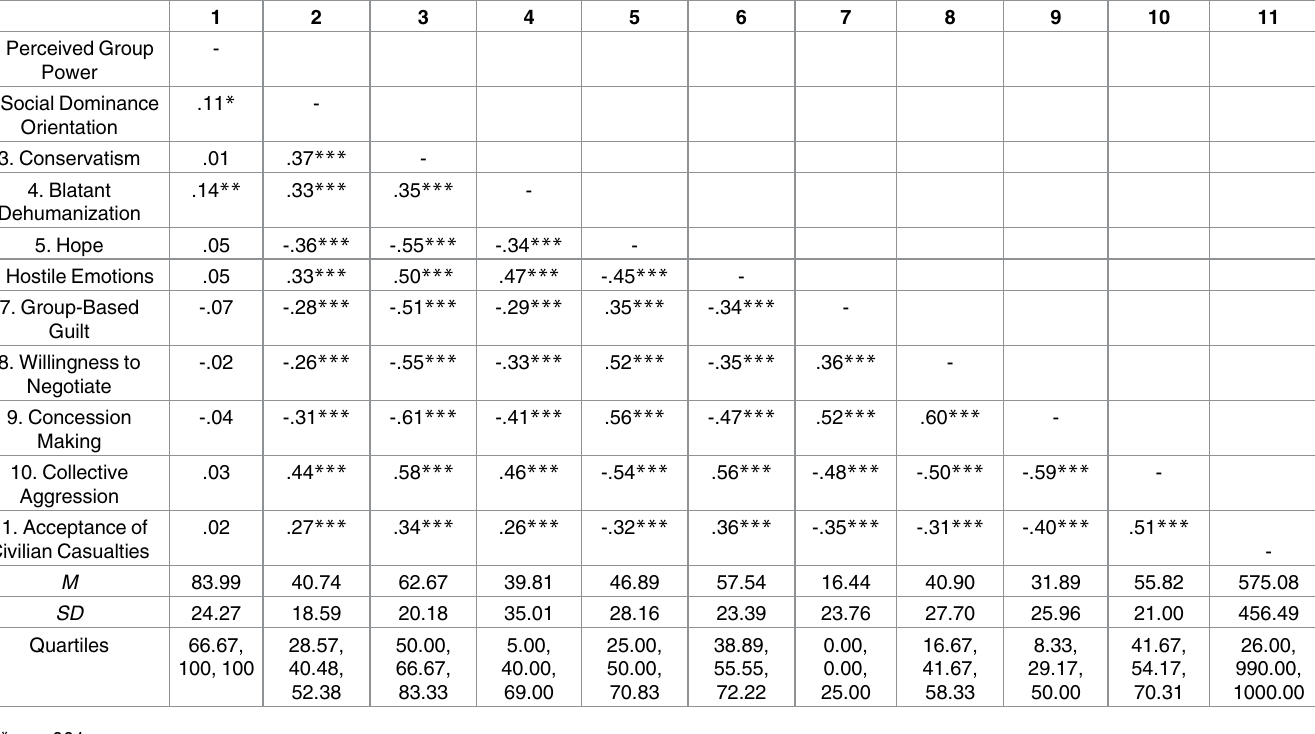
Table 1. Descriptivestatistics and variable intercorrelations for Study